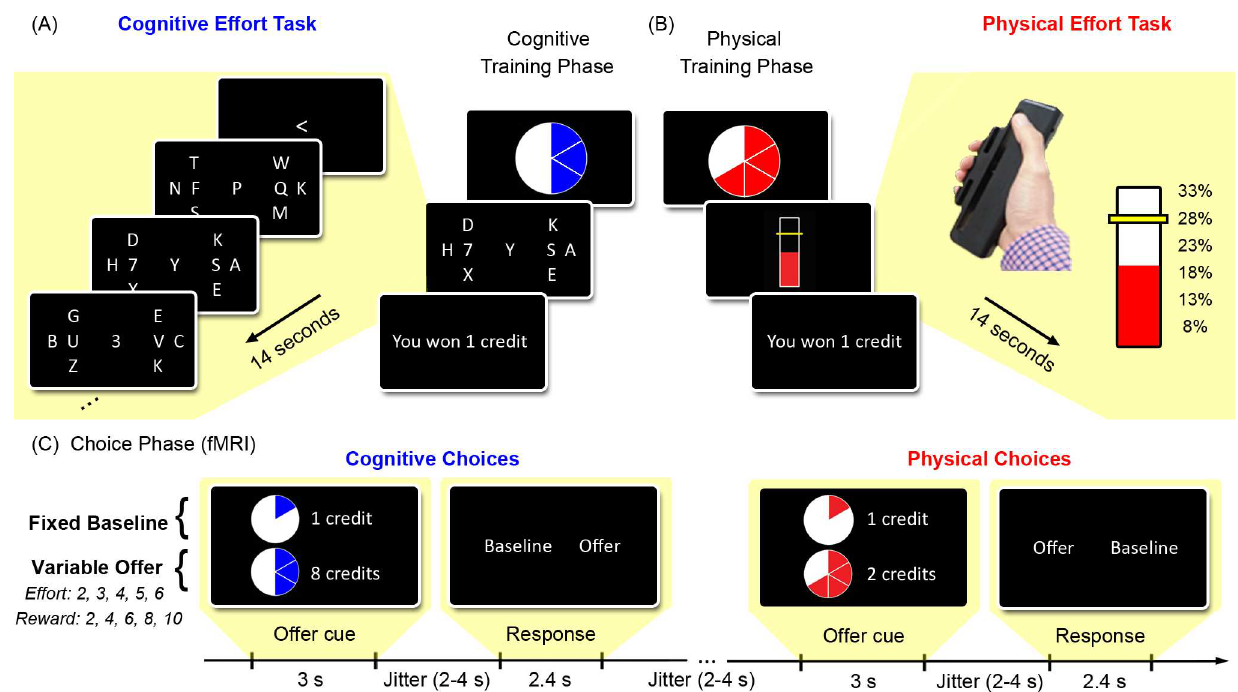
Fig 1. Cognitive and physical effort tasks. Upper Panel . Participants were first trained on the cognitive and physicaltasks. Each trial commenced with a pie chart indicatingthe upcomingeffort level. (A) The cognitiveeffort task utilisedan RSVP paradigm.The main task was to detect a target “7” in one of two letter streams at either side of fixation (here initiallyindicatedby “F” and “Q”). Each target stream was surroundedby three distractor streams. An arrowheadat the beginning of each trial indicatedthe initial target stream. During the trial, a central “3” was a cue to switch attentionto the oppositetarget stream. Cognitiveeffort was manipulatedas the number of attentionalswitches per trial (1–6). (B) The physicaleffort task requiredparticipantsto maintain a sustainedgrip on a handhelddynamometer at one of six levels of force, as a function of their individuallycalibrated maximal voluntarycontraction(MVC). Lower Panel . (C) After training, participants chose betweena fixed low-effort/low-reward baselineand a variable high-effort/high-rewardoffer. Choices were made while beingscanned with fMRI and were made separately for the cognitiveand physical